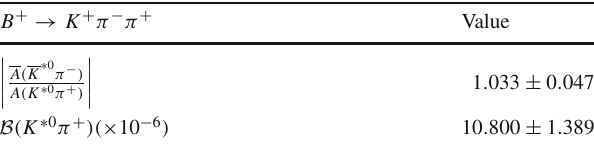
Table 3 Central values of the observables for the BaBar B + → K + π − π + analysis